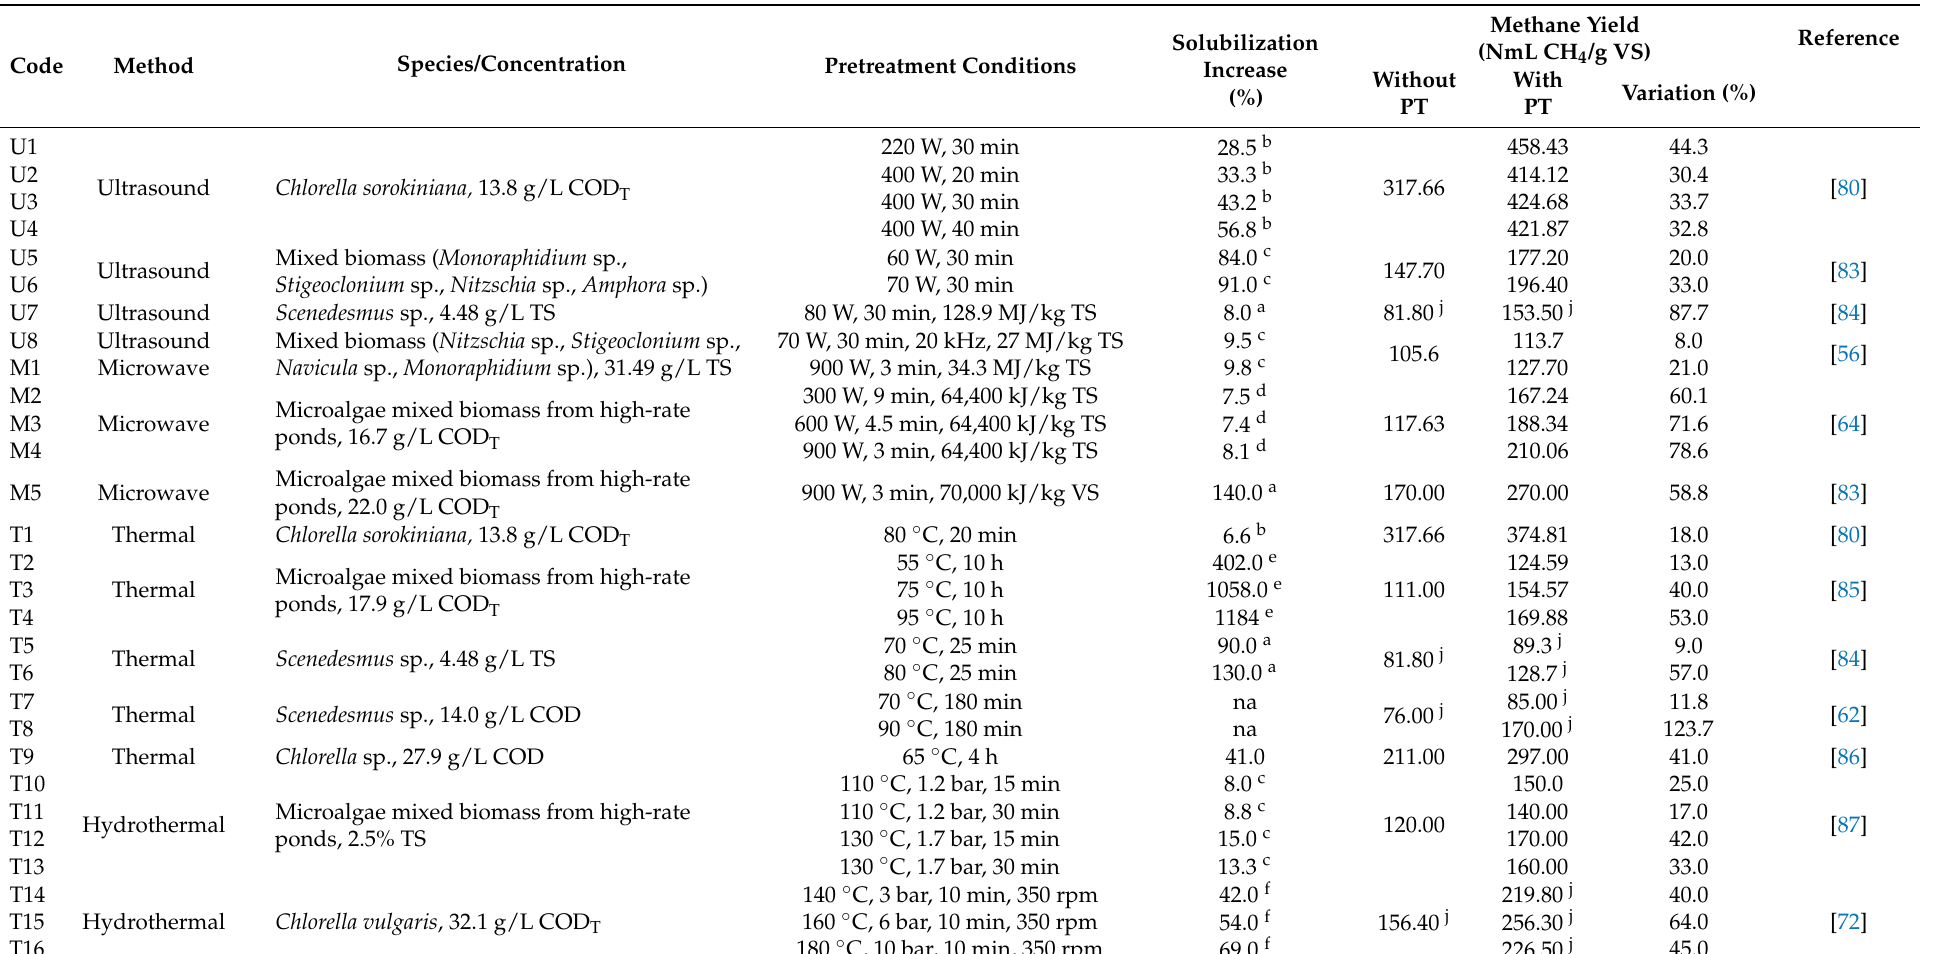
Table 3. Physical, thermal, and biological methods of microalgae pretreatment aimed at methane